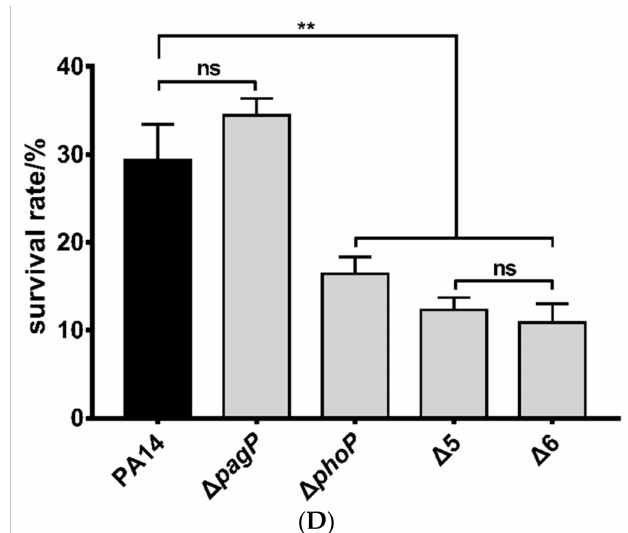
Figure 4. Roles of PhoP regulated genes in the bacterial tolerance to polymyxin B and SDS. ( A ) Dansyl- polymyxin B binding assay. Wild-type PA14 and the indicated mutants were treated with dansyl- polymyxin B (0.26 µ g/mL) for 5 min in saline at 30 ◦ C in dark. The bacteria were washed twice with saline and the fluorescence intensities were determined with a luminometer. The data shown represents the results from three independent experiments. ns, not significant; ***, p < 0.001 compared to the wild-type PA14 by Student’s t -test. ( B , C ) The indicated strains were grown to an OD 600 of 1.0 in the M9 medium, followed by treatment with 3.5 mM SDS at 37 ◦ C for 45 min. The bacteria were washed once with M9. Then the bacteria were subjected to serial dilution and plating on LB agar for CFU enumeration ( B ) or staining with 2 µ g/mL ethidium bromide and fluorescence intensity measurement ( C ). Data shown represent results from three independent experiments.